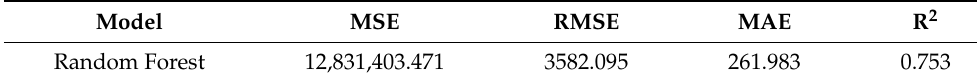
Table 9. Regression analysis result for games’ total ratings. Model MSE RMSE MAE R 2 Random Forest 12,831,403.471 3582.095 261.983